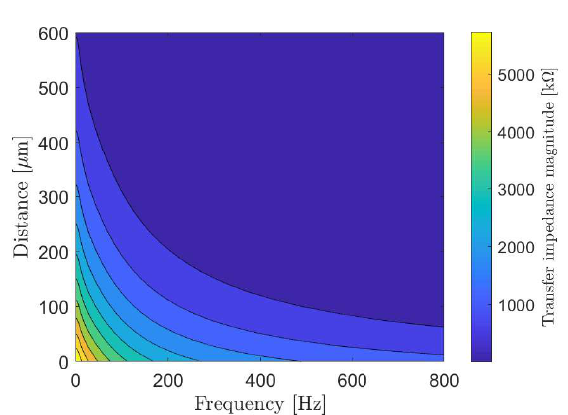
Figure 6. The transfer impedance of the subthreshold cardiac communication